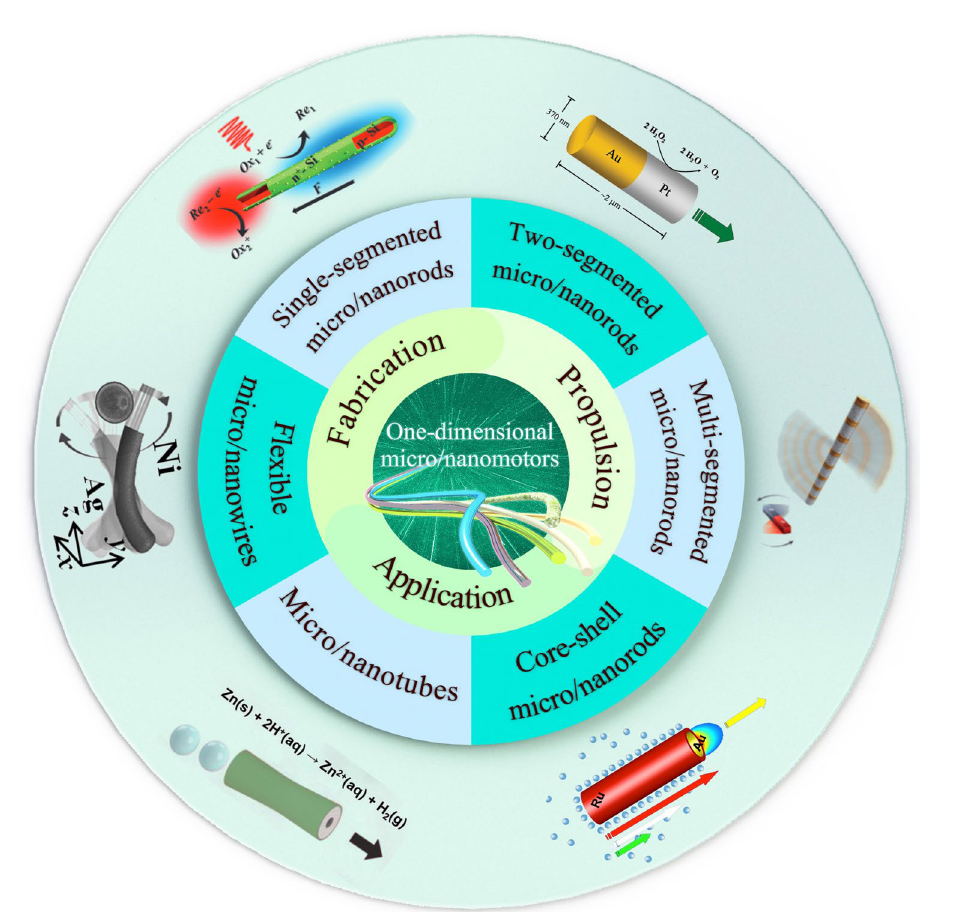
Fig. 1 Schematic diagram of common structures, drive principles and applications of 1D micro/nanomotors. Single-segmented micro/nanorods: reprinted with permission from Ref. [20]. Copyright (2014) American Chemical Society. Two-segmented micro/nanorods: reprinted with per- mission from Ref. [4]. Copyright (2004) American Chemical Society. Multi-segmented micro/nanorods: reproduced with permission from Ref. [21]. Copyright (2017) John Wiley & Sons. Core–shell micro/nanorods: reprinted with permission from Ref. [22]. Copyright (2016) American Chemical Society. Micro/nanotubes: reproduced with permission from Ref. [23]. Copyright (2017) Royal Society of Chemical. Flexible micro/ nanowires: reproduced with permission from Ref. [24]. Copyright (2012) John Wiley &